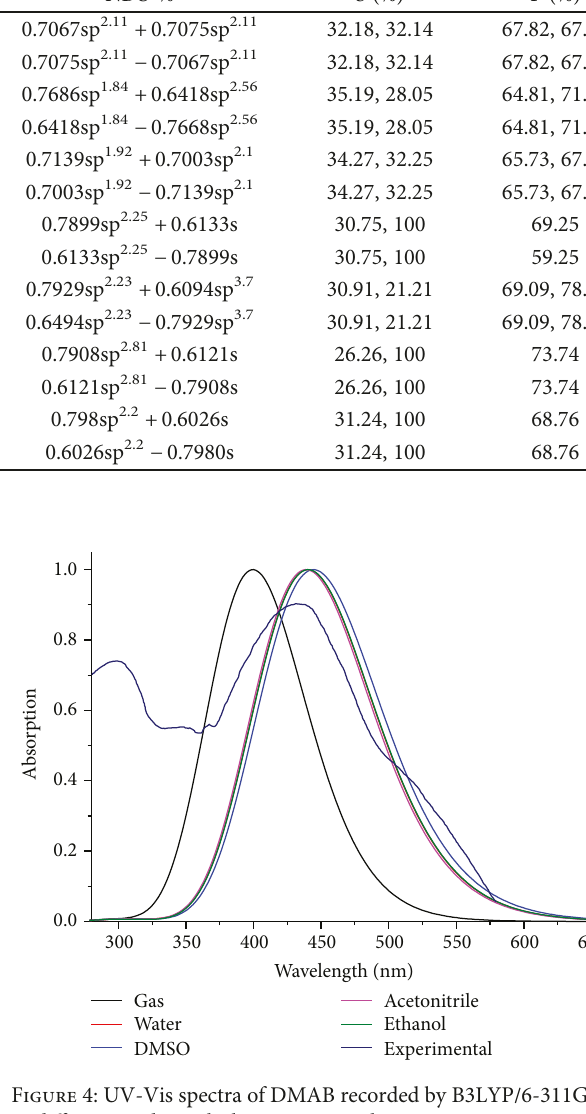
Table 3: Selected NBO results exhibiting the formation of Lewis and non-Lewis orbitals by valence hybrids at DFT/6-311G++ in gas. Bond